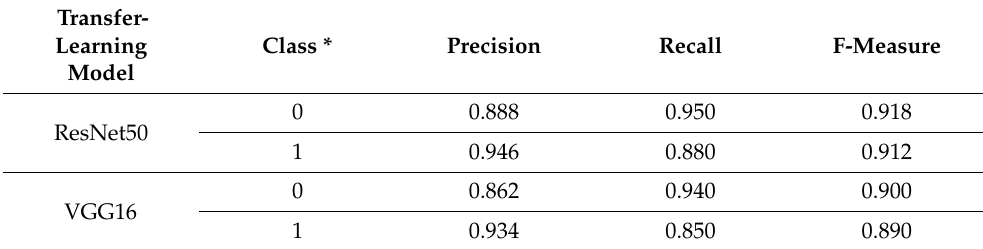
Figure 5. Classification of cells using CNN. ( a ) Scheme of CNN used to classify cell image datasets that were differently recognized by the AI model of CGAN. ( b , c ) Performing classification using transfer learning with ( b ) ResNet50 and ( c ) VGG16. Learning was performed in 20 epochs with a batch size of 100 per epoch for training datasets of 1- and 2-day cultures. ( d ) Visualization of CNN prediction. Output examples of cell images classified into 0 for a 1-day image and 1 for a 2-day image. Heat map from blue to red shows the magnitude of the probability of prediction from low to high using Grad-CAM and Grad-CAM++. Bars = 100 µ m. ( e ) Visualization of CNN image classification into center and whole of a 1-day dataset. Grad-CAM prediction illustration was performed using the heat map. Arrow and arrowhead indicate prediction using guided Grad-CAM. Inset is a zoomed region shown by an arrowhead. Bars = 100 μ m. Table 1. Classification of CSC images of different culture periods using CNN.